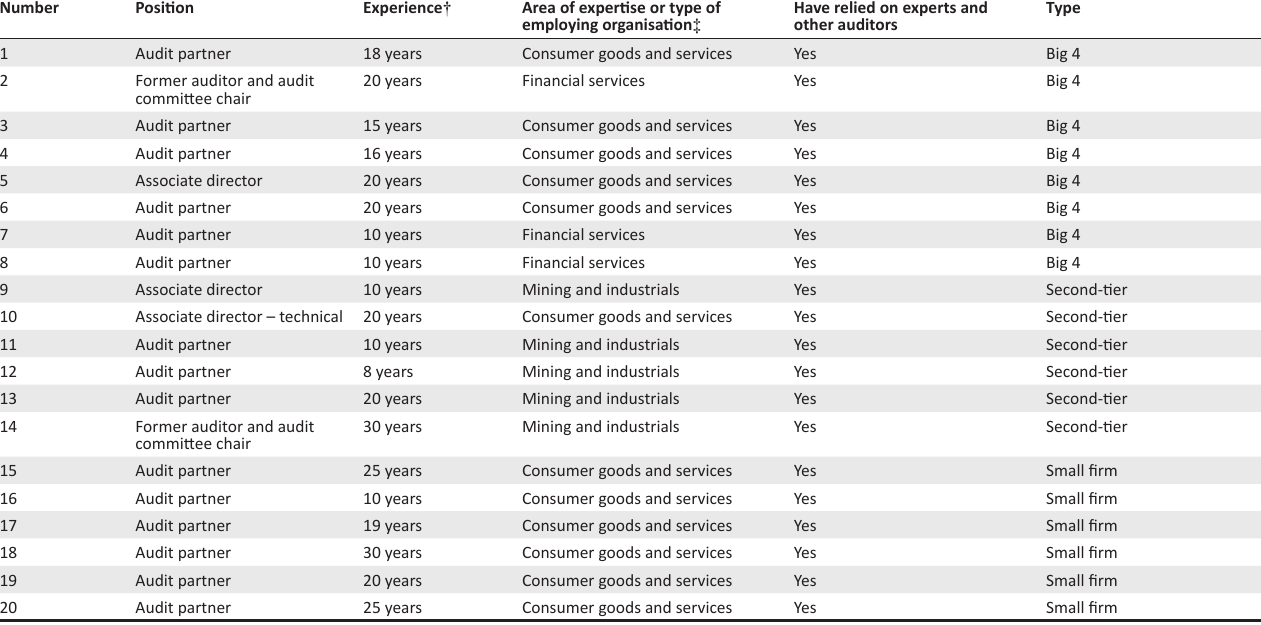
TABLE 1-A1: List of respondents: Assurance